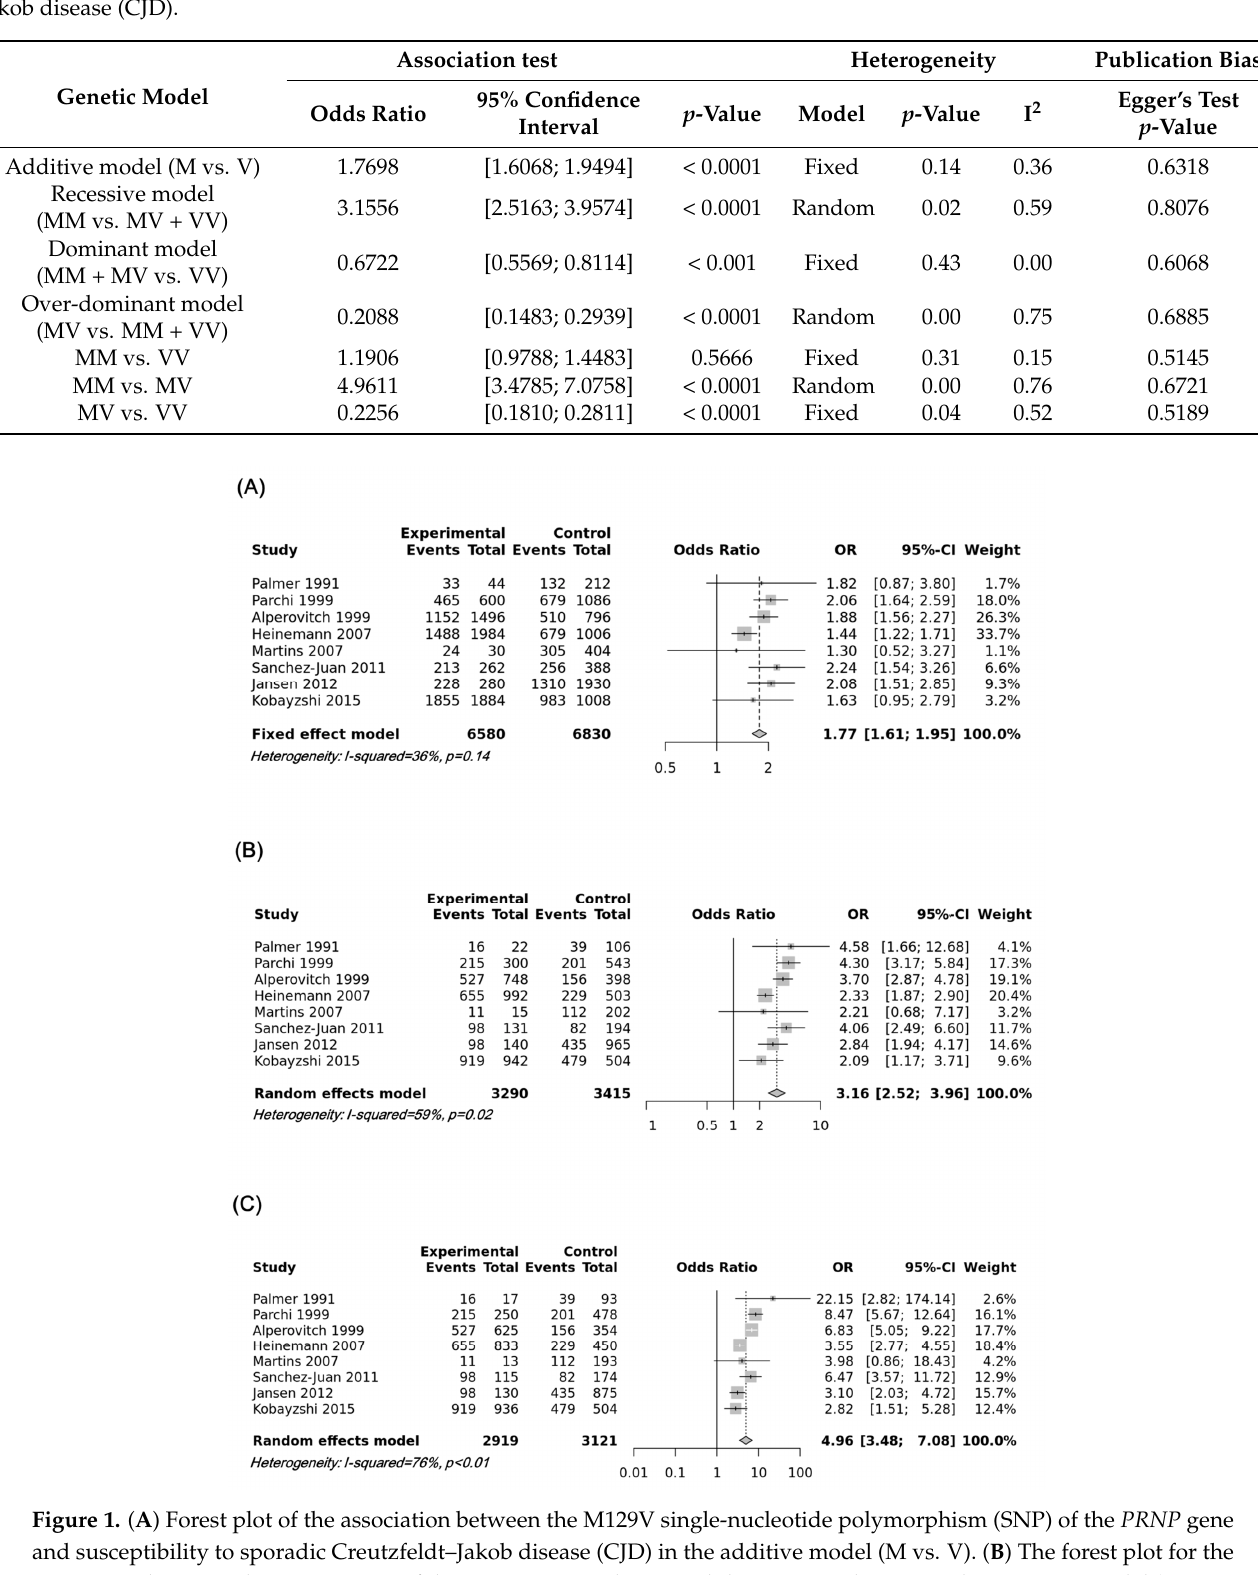
Table 2. Meta-analysis of the association between M129V of the prion protein gene ( PRNP ) and susceptibility to sporadic Creutzfeldt– Jakob disease (CJD).